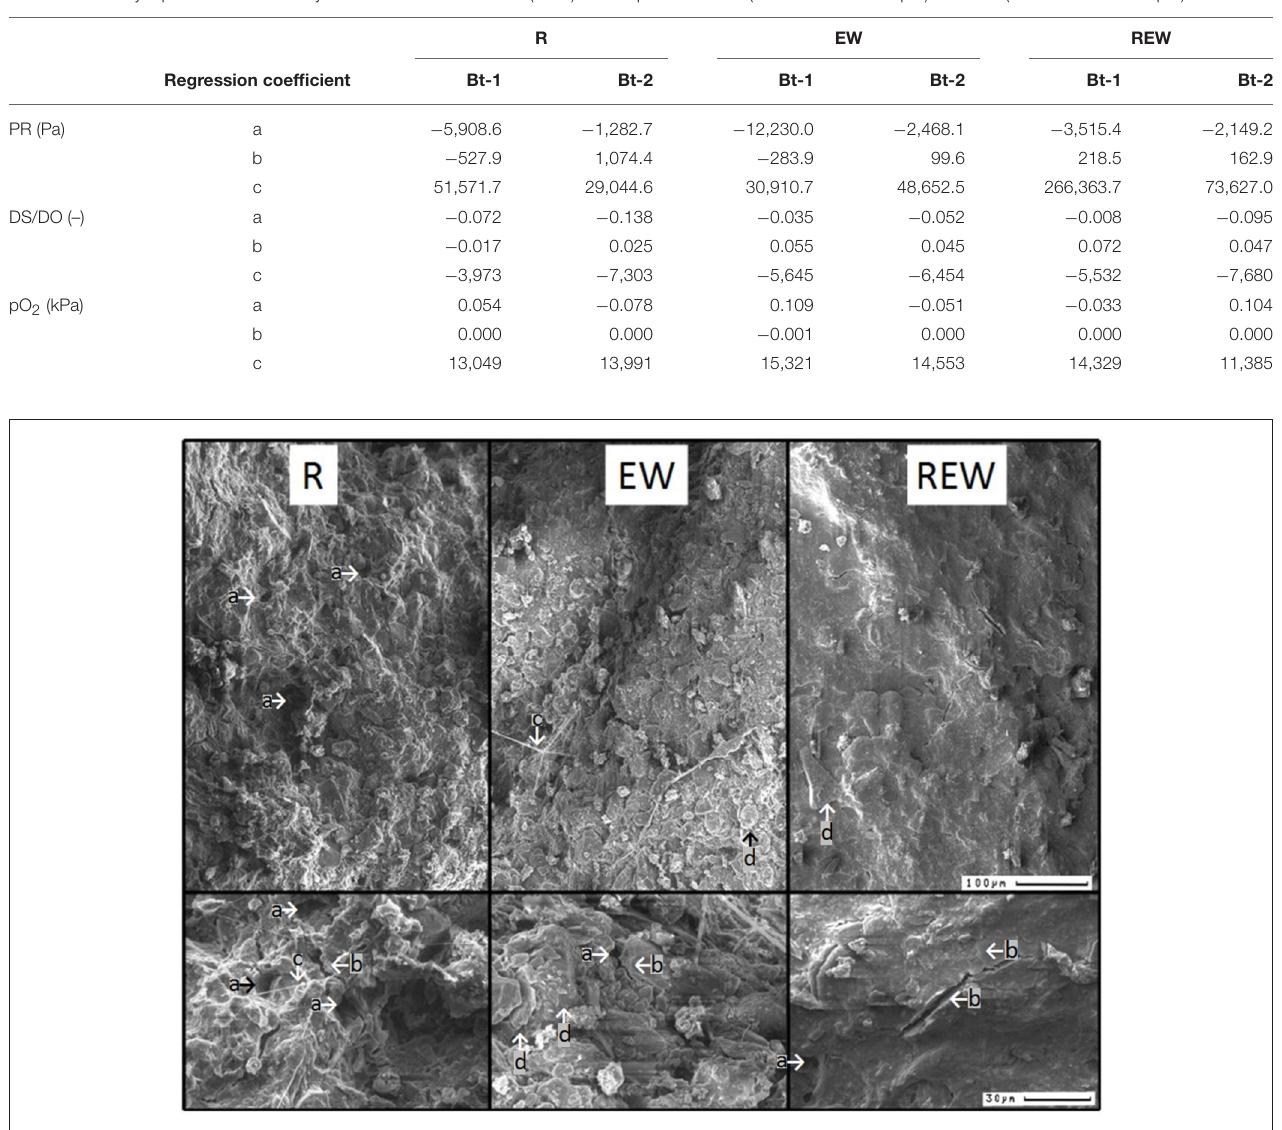
TABLE 3 | Regression coefficients according to Equation (4) for penetration resistance (PR, Pa), relative oxygen diffusion coefficient (D s /D O ) and oxygen partial pressure (pO 2 ) for biopores colonized and/or created by chicory ( Cichorium intybus L. ) roots (R), colonized and/or created by Lumbricus terrestris (EW), and biopores colonized and/or created by a plant root followed by colonization of L. terrestris (REW) for samples from Bt-1 (0.45–0.55m soil depth) and Bt-2 (0.55–0.65m soil depth).